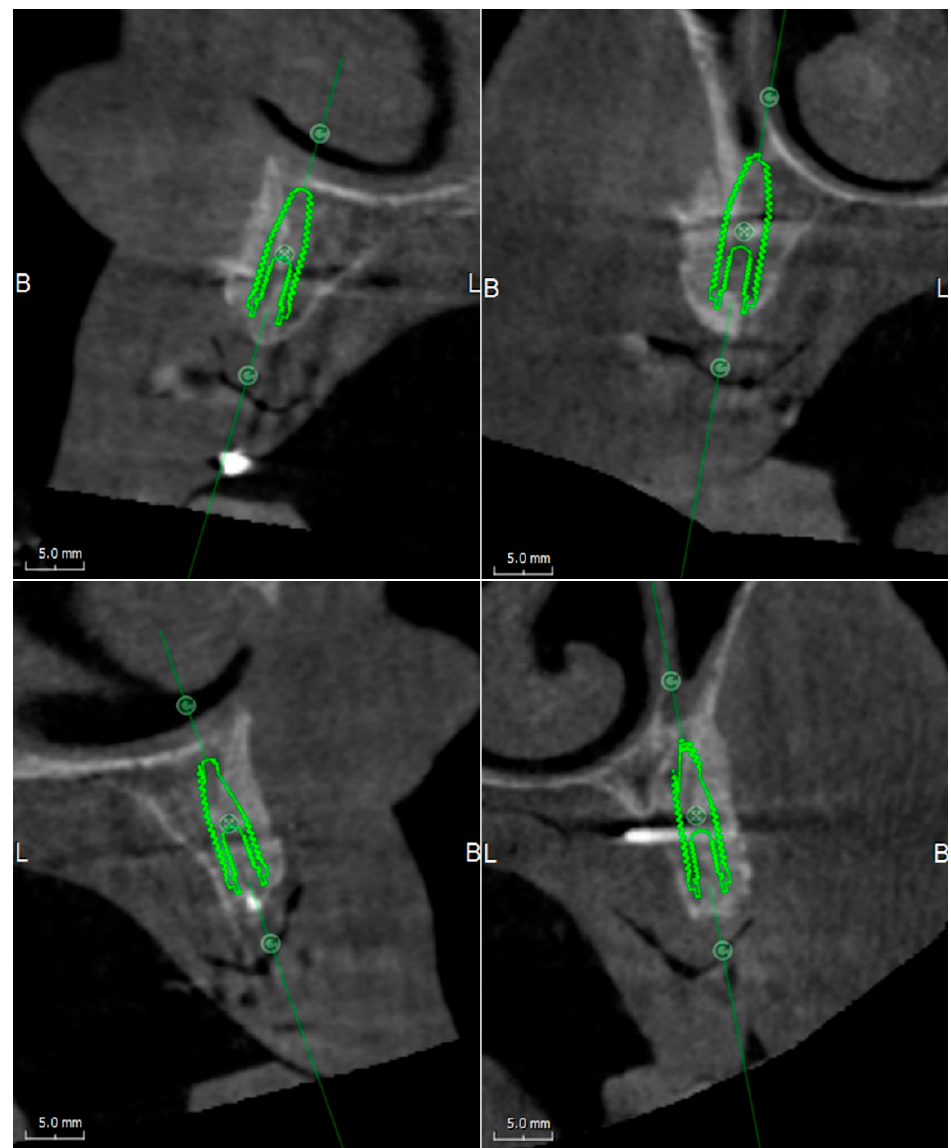
Figure 5. CBCT, performed at six months after reconstructive surgery, shows the integration of grafted blocks at planned implant sites.